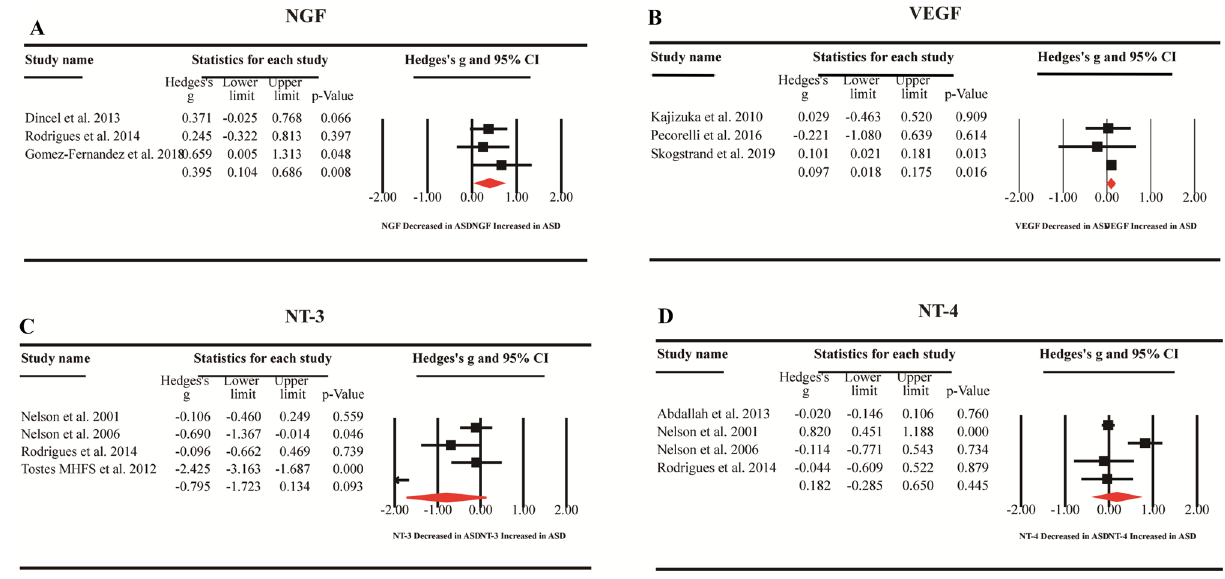
Figure 3. Forest plot for random-effects meta-analysis for NGF, VEGF, NT-3 and NT-4. Forest plot for random- effects meta-analysis on differences in blood NGF ( A ), VEGF ( B ), NT-3 ( C ) and NT-4 ( D ) concentrations between children with autism spectrum disorder (ASD) and healthy controls. The sizes of the squares are proportional to study weight. Diamond marker indicates pooled effect size. CI, confidence interval.